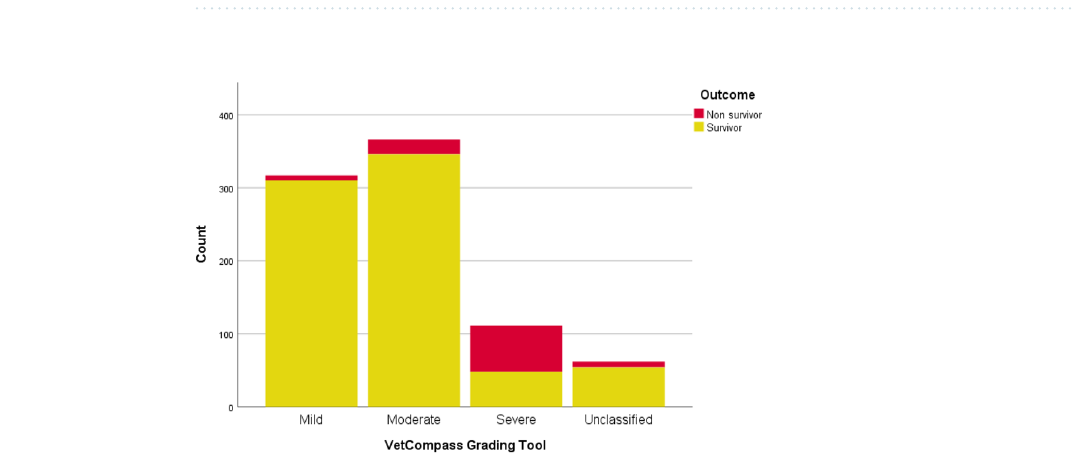
Table 5. Development of the novel VetCompass Clinical Grading Tool for Heat-Related Illness in dogs, based upon the JAAMHC human heat-related illness scale.